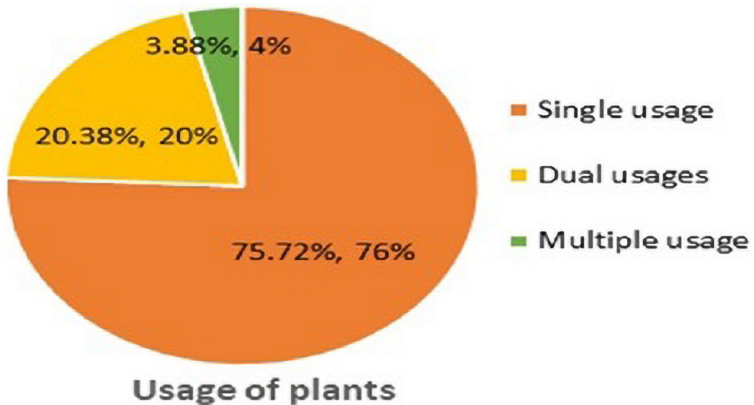
Fig 3. Graphical presentation of plants on the basis of their usage from study area of Dawarian and Rati Gali, District Neelam of Azad Jammu and Kashmir, Pakistan.